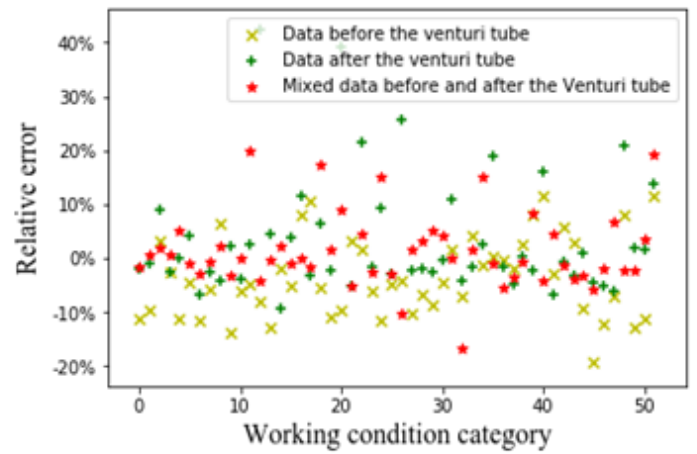
Figure 9. Relative error of oil flow rate with CNN algorithm.